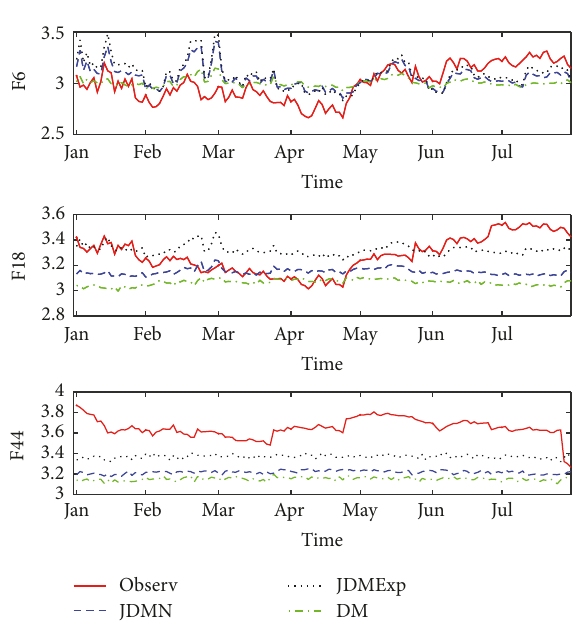
Figure 2: Natural gas futures prices (January–July 2015) with maturities: 6, 18, and 44 months. The NYMEX futures prices are the red solid line, the DM is the green dashed dotted line, the JDMN is the blue dash line, and the JDMExp is the black dotted